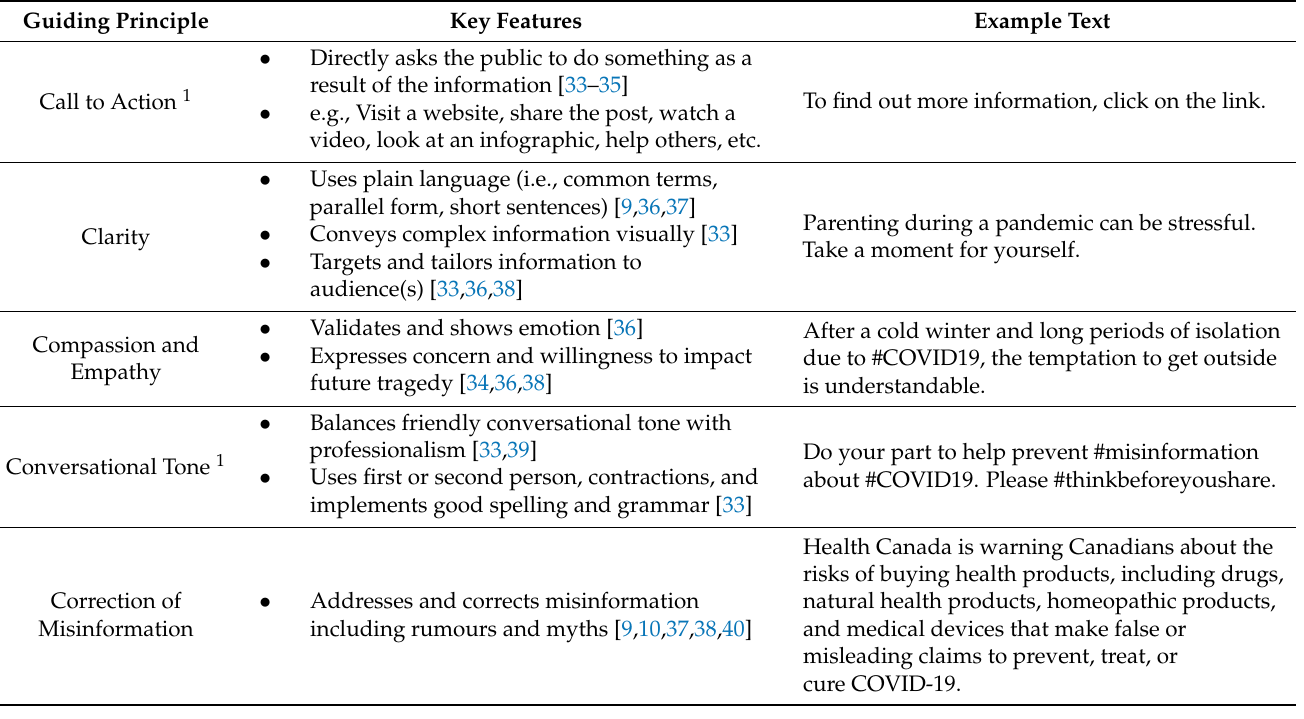
Table 1. Key features of guiding principles for crisis communication using social